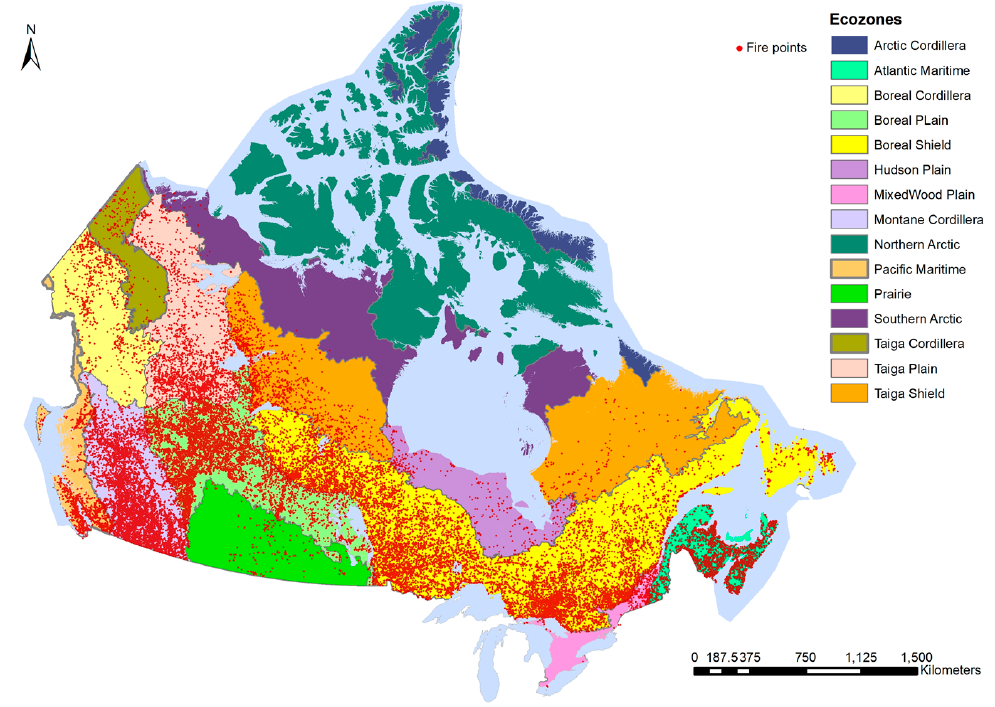
Figure 1. Spatial distribution of all fires over a 8-year period (2010–2017), over various ecozones in Canada. The red dots indicate the fire locations. The main ecozones considered are the Boreal Shield, Boreal Plain, Atlantic Maritime, Pacific Maritime, Taiga Plain, and the Taiga Shield.